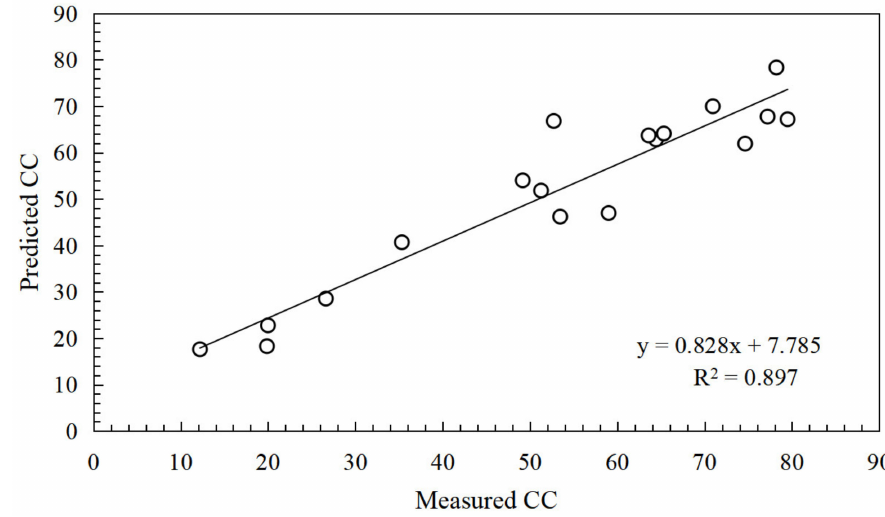
Figure 7. Model validation: agreement between the measured and predicted 18 plots of